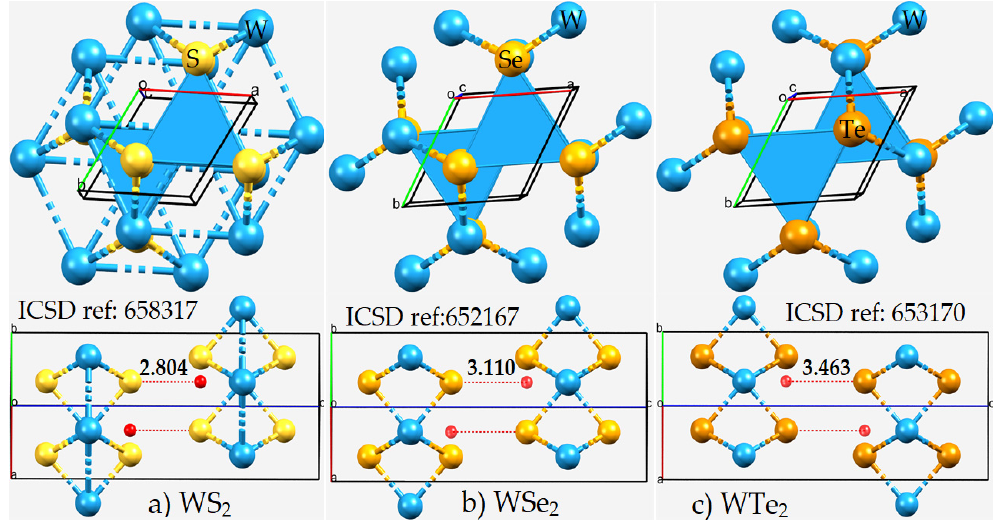
Figure 3. The top and side views of the unit-cells of ( a ) WS 2 , ( b ) WSe 2 , and ( c ) WTe 2 in the 2H-phase, consisting of hexagonal triatomic layers, Ch–W–Ch, with a plane of metal atoms bound to two planes of chalcogen atoms (see Figure 1). The Inorganic Crystal Structure Database (ICSD) references to the structures are given. The distance between the W-bonded Ch site in an WCh 6 unit in a monolayer and the centroid of the triangular face formed by three nearest Ch sites in the same unit in the neighboring layer (tiny red sphere) is shown in Å. Each structure is crystallized in the space group P6 3 /mmc . In the case of WTe 2 , the interlayer Ch ··· Ch bond distance in the crystal geometry is 4.007 Å and is within the radii error limit of twice the van der Waals radius of Te. This suggests that there is no van der Waals gap between the layers in either of the three crystal systems, as the Ch sites of the two interacting monolayers are bonded with each other through weak attractive forces (vide infra). That there is no physical gap (only voids) between the monolayers of WCh 2 is also evident from the space-filling model shown in Figure 4, in which, the S atoms of each of the two monolayers are not only just facing each other, but “kissing” [57–59]. Further evidence of mutual penetration between the bonded atomic basins that emerges from a QTAIM analysis is discussed below.